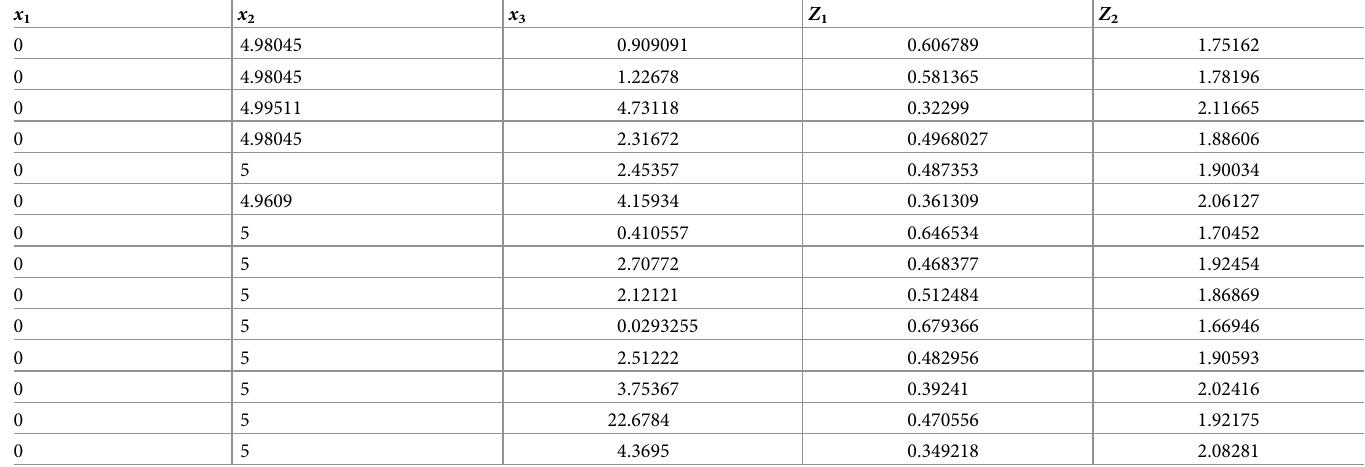
Table 1. Non dominated solutions and values of Z 1 and Z 2